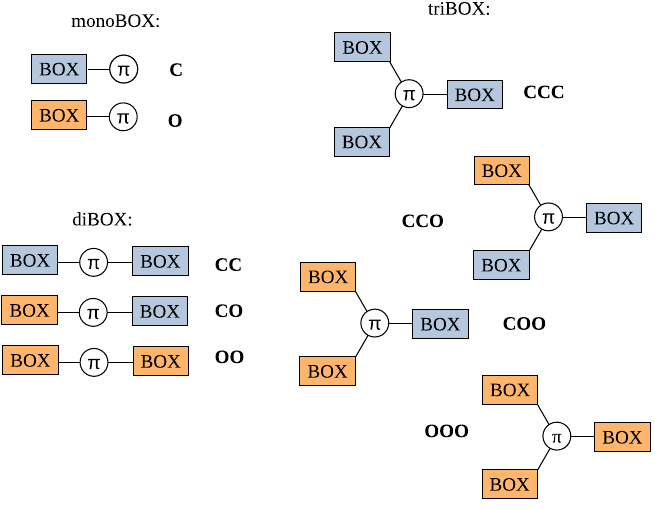
Figure 2. Schematic representation of the different forms associated with a monoBOX, diBOX, or triBOX, as a function of the closed ( C ) or open ( O ) state of each BOX